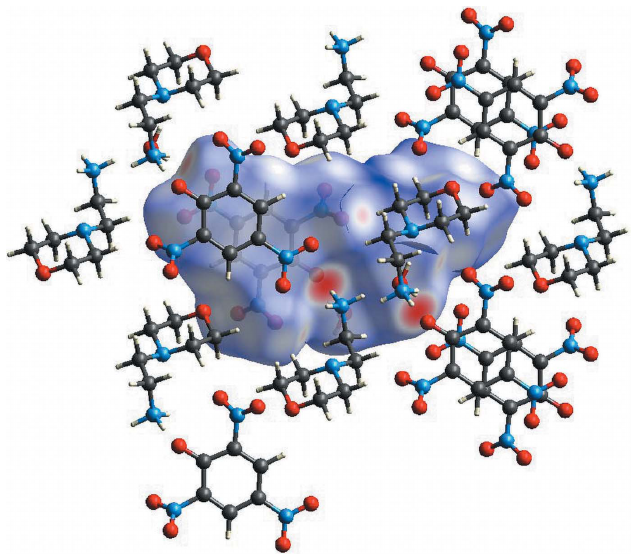
Figure 7 The Hirshfeld surface of the title compound mapped over d norm , showing the closest molecules.